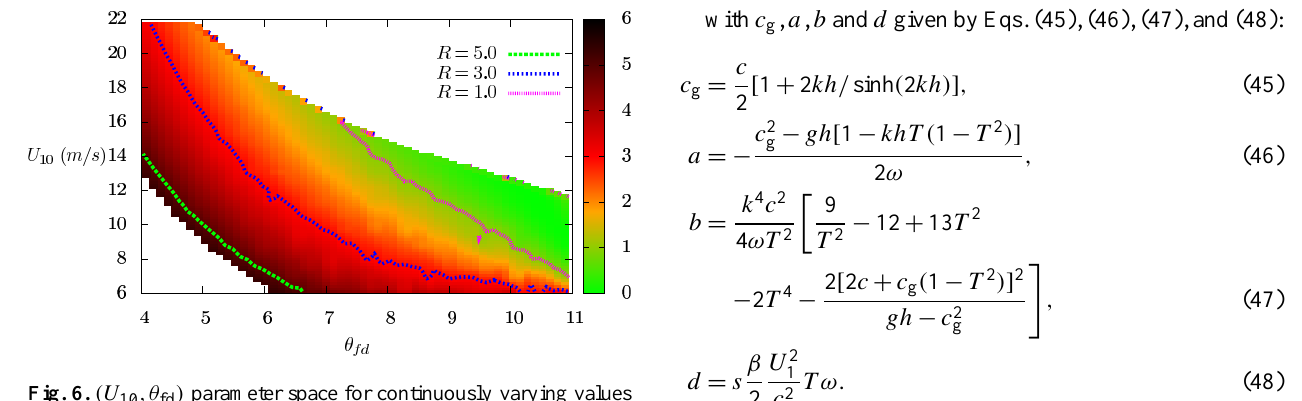
Fig. 6. (U 10 ,θ fd ) parameter space for continuously varying values of R = 0 J /0 M . In the domain defined by R < 1, the Miles mech- anism is dominant, whereas for R > 1 the Jeffreys mechanism is